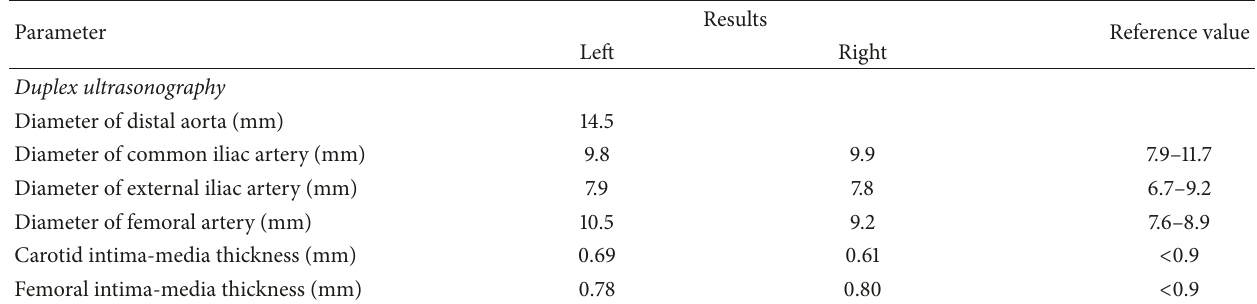
Table 3: Vascular diameter and intima-media thickness.